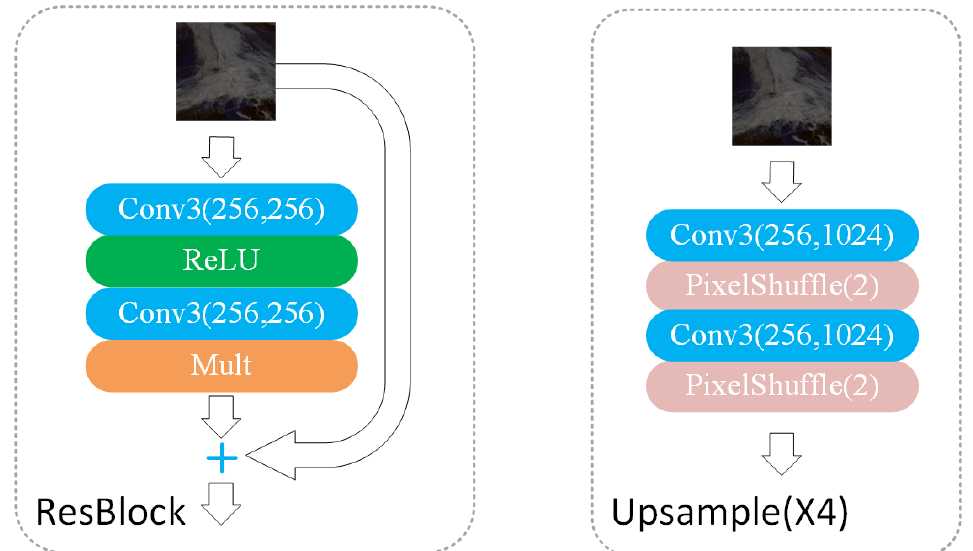
Figure 4. Blocks in